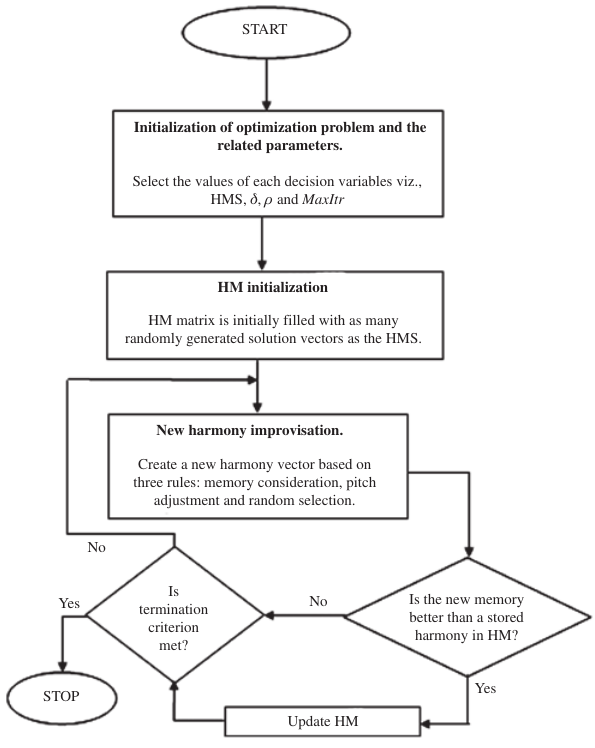
Figure 3: Flowchart of the HSA